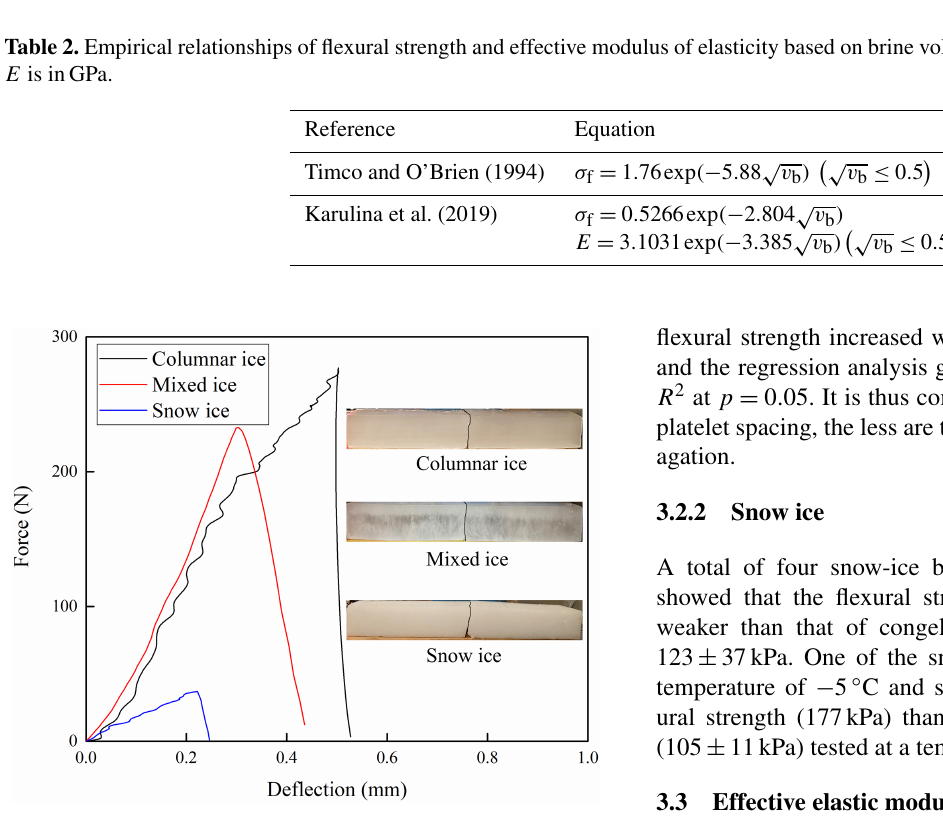
Figure 5. Typical curves of force versus deflection at the middle of a beam with corresponding broken sections depicted by black lines shown in